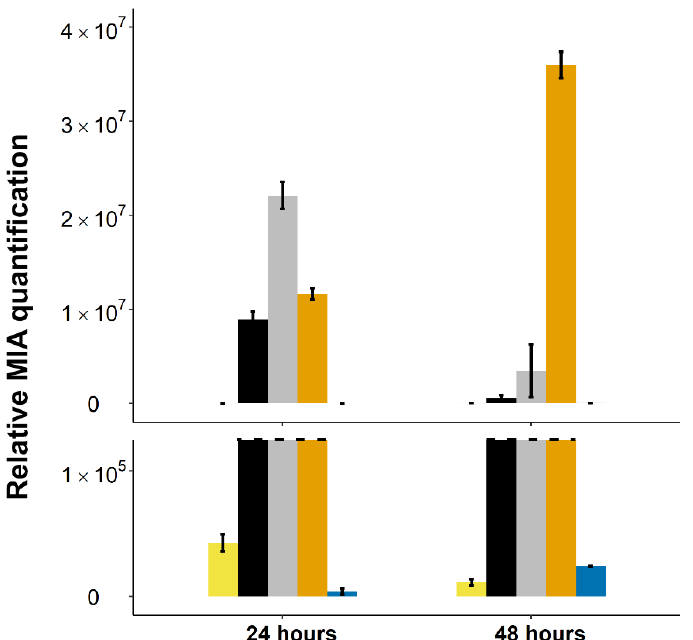
Figure 7. Evolution of MIA biosynthetic intermediates in the medium culture of yeast harboring episomal plasmids containing two copies of T16H2 and C. roseus 16OMT and one copy of T3O (2(16OMTs)_T3O strain). Alkaloids were quantified by UPLC ‐ MS in the yeast culture medium 24 h post ‐ feeding with tabersonine (250 μ M). The dashed line represents the scale cut for the visualization of low accumulated intermediates. Error bars correspond to the standard error of biological replicates ( n = 3). Light yellow = tabersonine, black = 16 ‐ hydroxytabersonine, grey = 16 ‐ methoxytabersonine, dark yellow = 16 ‐ methoxytabersonine epoxide, blue = tabersonine epoxide. MIA composition of the yeast culture medium is expressed as relative peak areas.